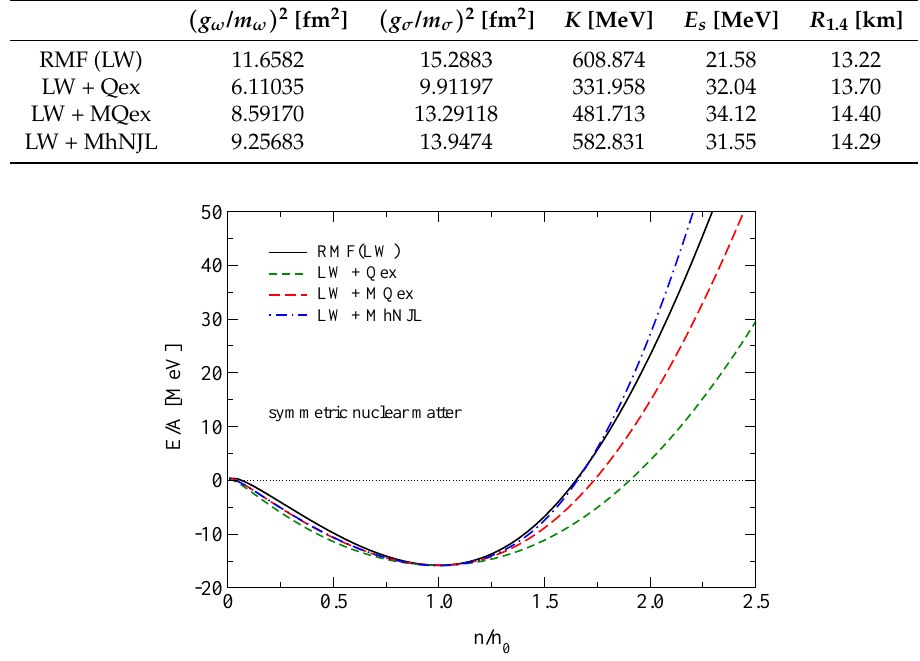
Figure 4. Energy per nucleon of symmetric matter for relativistic mean-field (RMF) (LW) (solid lines), LW + Qex (dashed lines) and LW + MQex (long-dashed lines) models.